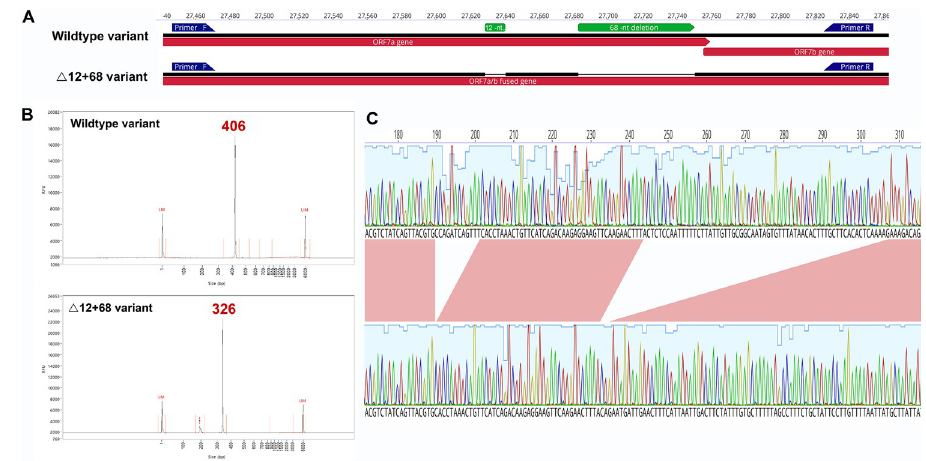
Fig 1. A: ORF7a amplicon for the wildtype and Δ 12+68 variants. Artic primers annotations are visualized by blue arrows. B: Chromatogram peaks after capillary electrophoresis, wildtype, and Δ 12+68 variants. C: Zoomed diagram details nucleotide sequence of the double deletion obtained by Sanger sequencing.